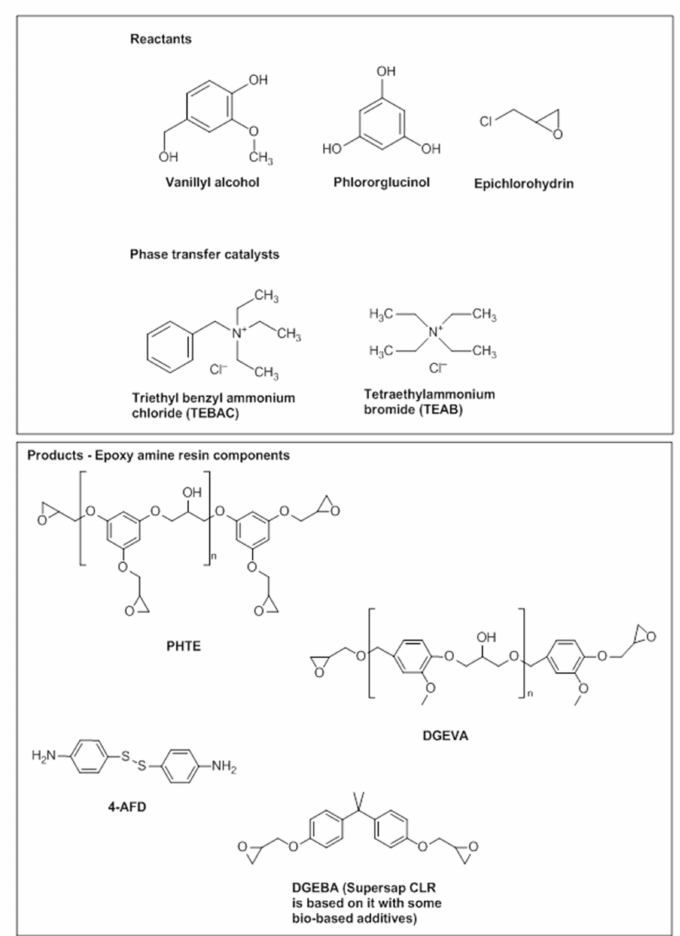
Figure 1. Structural formula of the used reactants and obtained